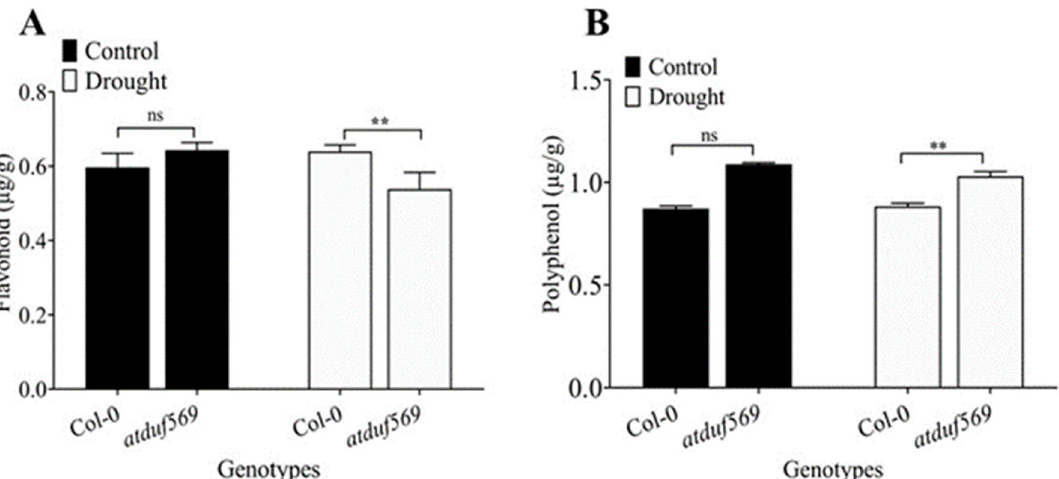
Figure 7. Total flavonoid and polyphenol content in the leaves of Arabidopsis plants under drought stress. ( A ) Total flavonoid and ( B ) total polyphenol contents of WT Col-0 and atduf569 knockout mutant Arabidopsis genotypes under drought and control conditions. Data represent means of values obtained from experiments performed in triplicate. Error bars represent standard deviation. Means were analyzed for significant differences using Student’s t -test. Asterisks ** indicate significant whereas “ns” indicate non-significant differences at 5% level of significance (** p < 0.01).